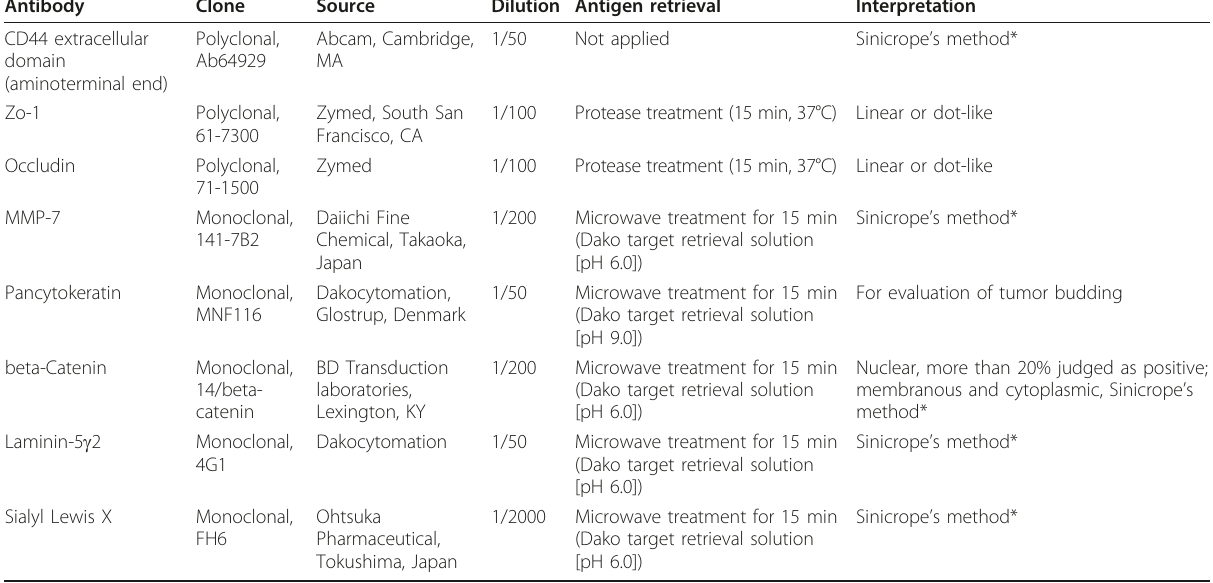
Table 1 Antibodies used for the immunohistochemical examination Antibody Clone Source Dilution Antigen